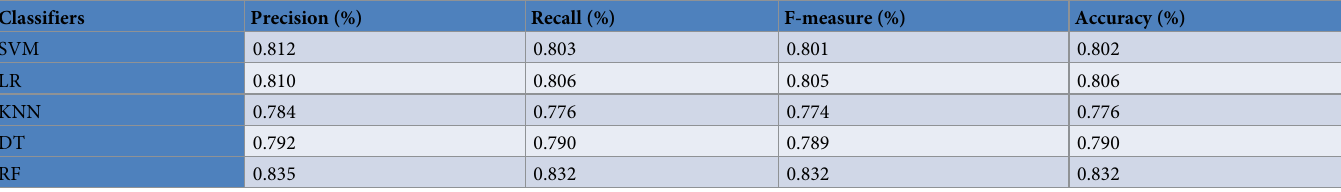
Table 8. Performance results obtained by considering lexical feature